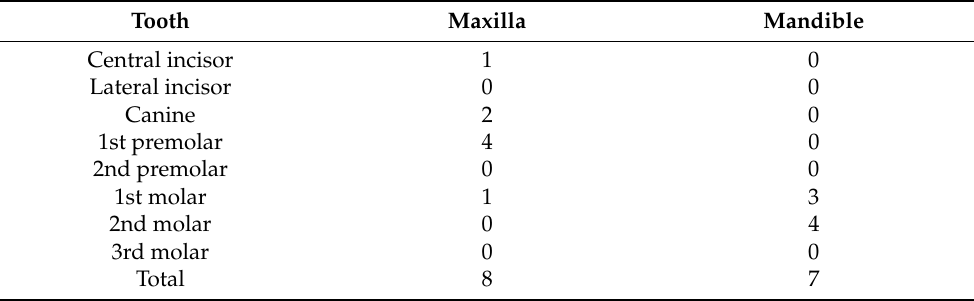
Table 2. Distribution of restorations according to the tooth location. Tooth numbers 1 to 8 sequentially correspond to the teeth in a quadrant (from anterior to